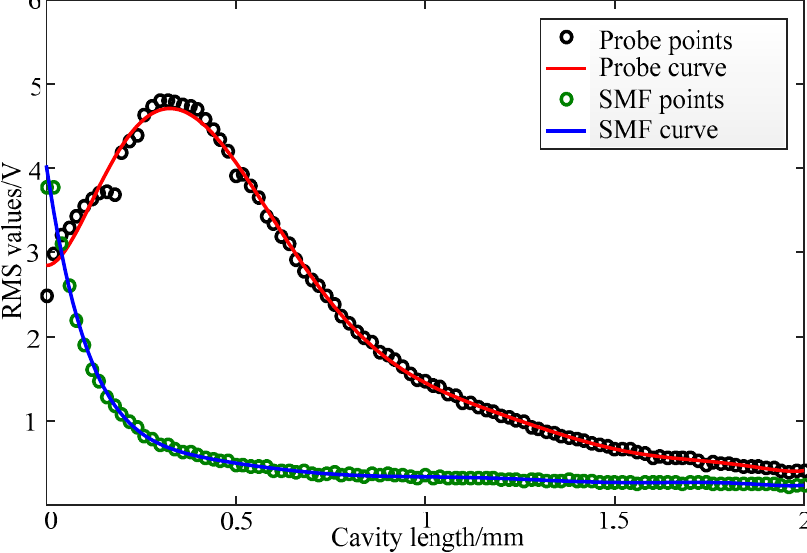
Figure 8. A comparison of the root mean square (RMS) values of the novel F–P interferometer and the ordinary F–P interferometer.